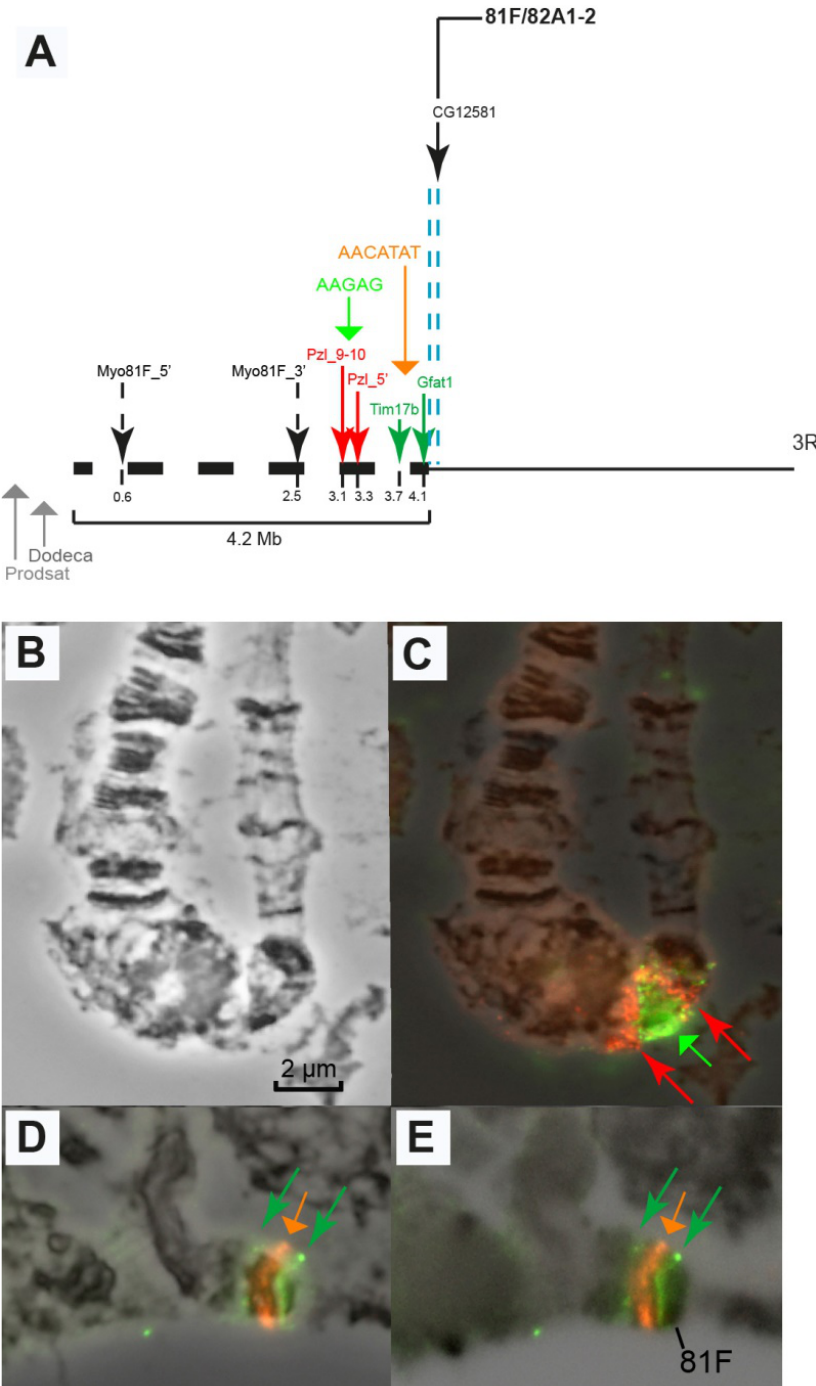
Figure 10. Localization of the probes from the Pzl gene, the AAGAG satellite in the intron of this gene ( A – C ), and the AACATAT satellite between the Tim17b and Gfat1 genes in 3R heterochromatin ( D , E ). ( A ) Physical map; ( B , C ) AAGAG satellite in a polytene chromosome (green arrow) in the intron of the Pzl gene (red arrows point to the Pzl9-10 and Pzl 5’ probes to the left and right of the green arrows, respectively); ( D , E ) mutual localization of the AACATAT satellite (orange arrow) and the Tim17b and Gfat1 genes on the left and right, respectively (green arrows). Phase ( D ) and DAPI invert ( E ). The genotype in all figure parts is Rif1 1 ; SuUR ES Su(var)3-9 06 . Scale bar value is the same for every figure.